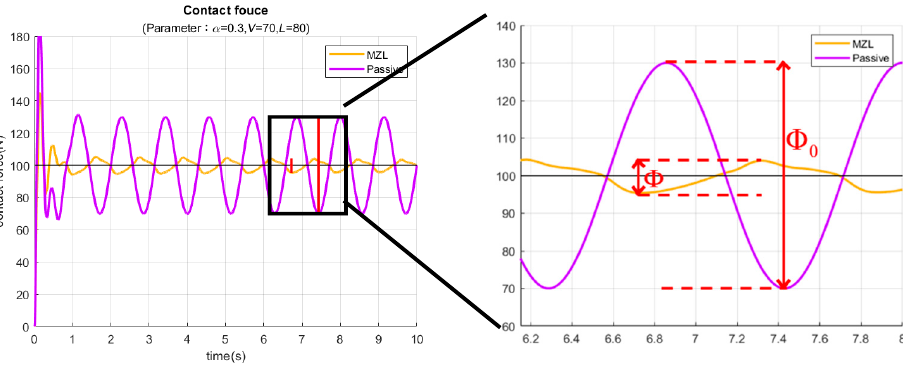
Figure 8. The definition of the Φ and Φ 0 for